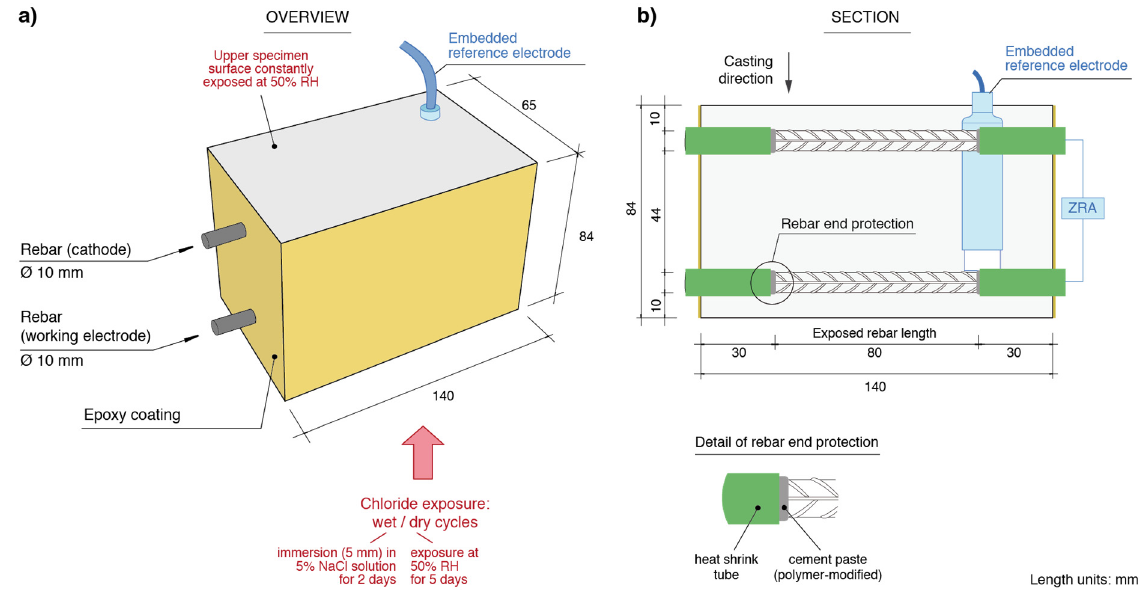
Figure 3: Example of a drawing of the specimen showing all relevant geometrical dimensions, including details about the exposure conditions and the electrochemical instrumentation. a) overview, and b) section. Yellow indicates the epoxy coating, red the exposure conditions, green the rebar end protection measures, and blue electrochemical measurement instrumentation (ZRA = zero resistance ammeter). (Courtesy of U.